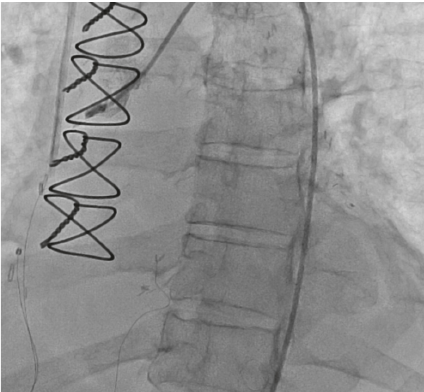
Figure 3: Left heart catheterization showing occlusion of SVG graft to